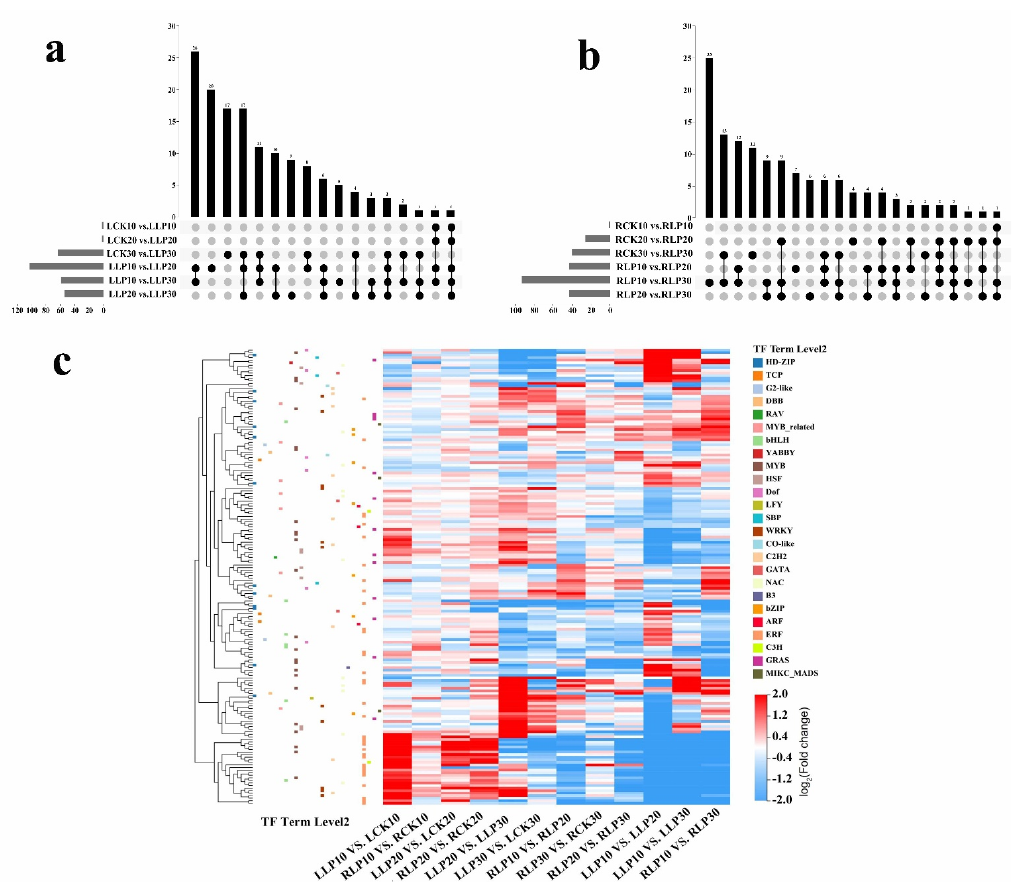
Figure 9. Analysis of differentially expressed TFs in M. mandshurica under low − Pi treatment. Venn diagram of ( a ) Leaves and ( b ) Roots. ( c ) Heat map of differential expression of TFs.